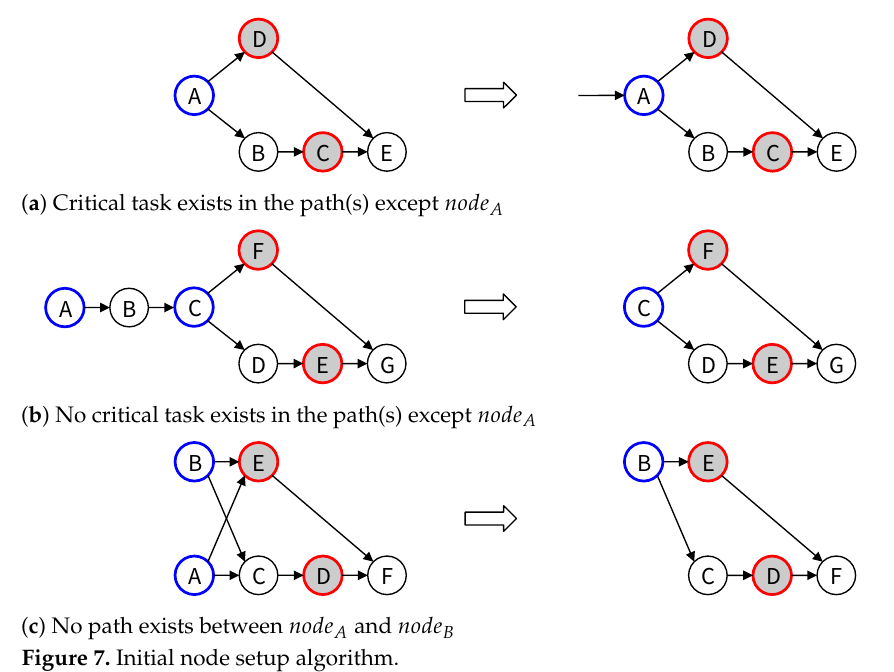
Figure 7. Initial node setup